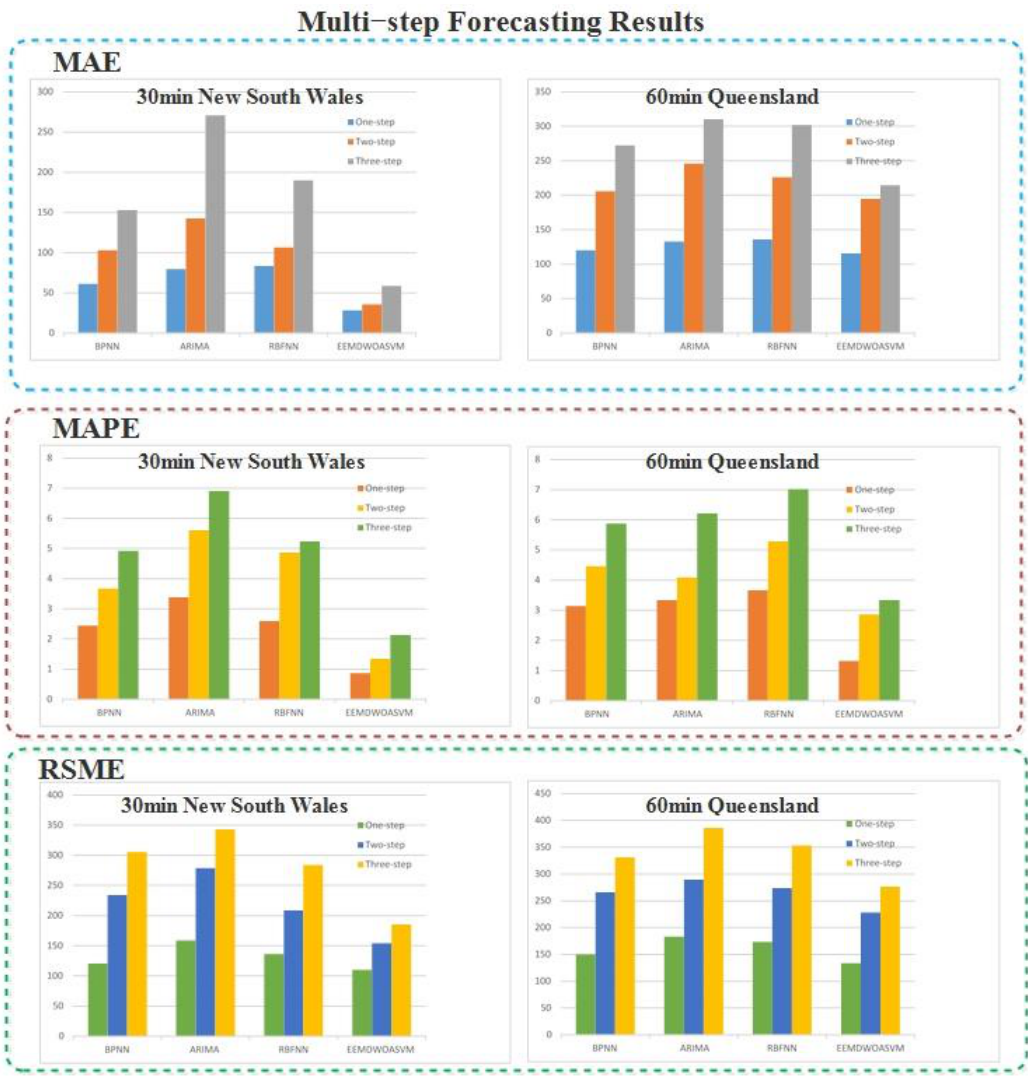
Figure 4. Multi-step forecasting results of different models using data from New South Wales and Queensland.